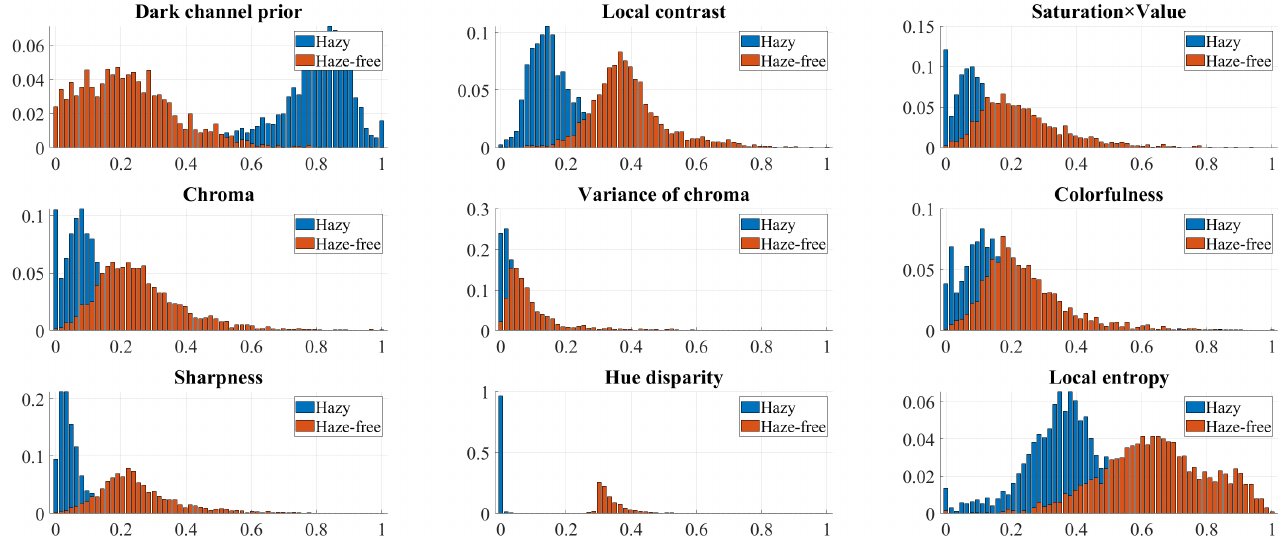
Figure 3. The normalized histograms of nine haze-relevant features. The horizontal axis is the normalized feature value, and the vertical axis is the pertinent frequency of